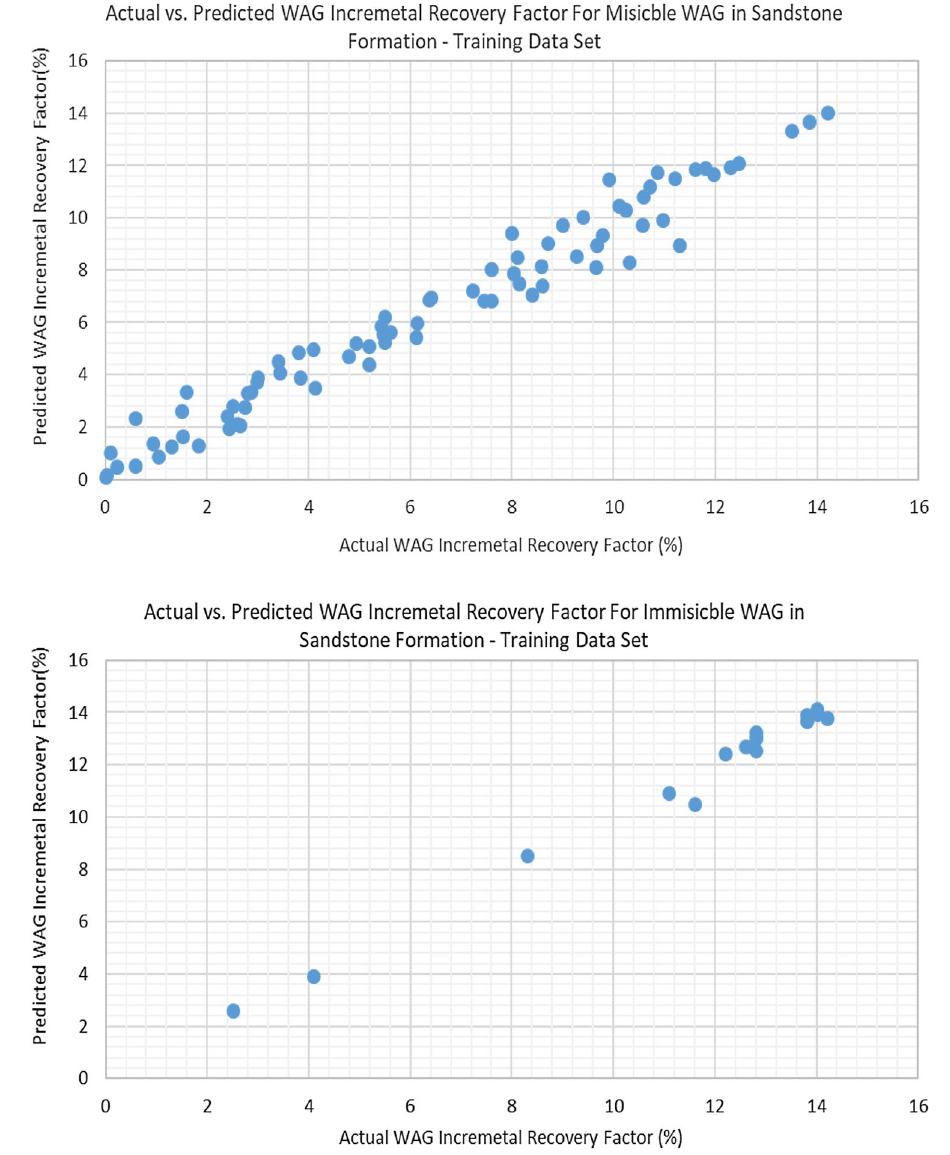
Fig. 14 GMDH WAG incre-